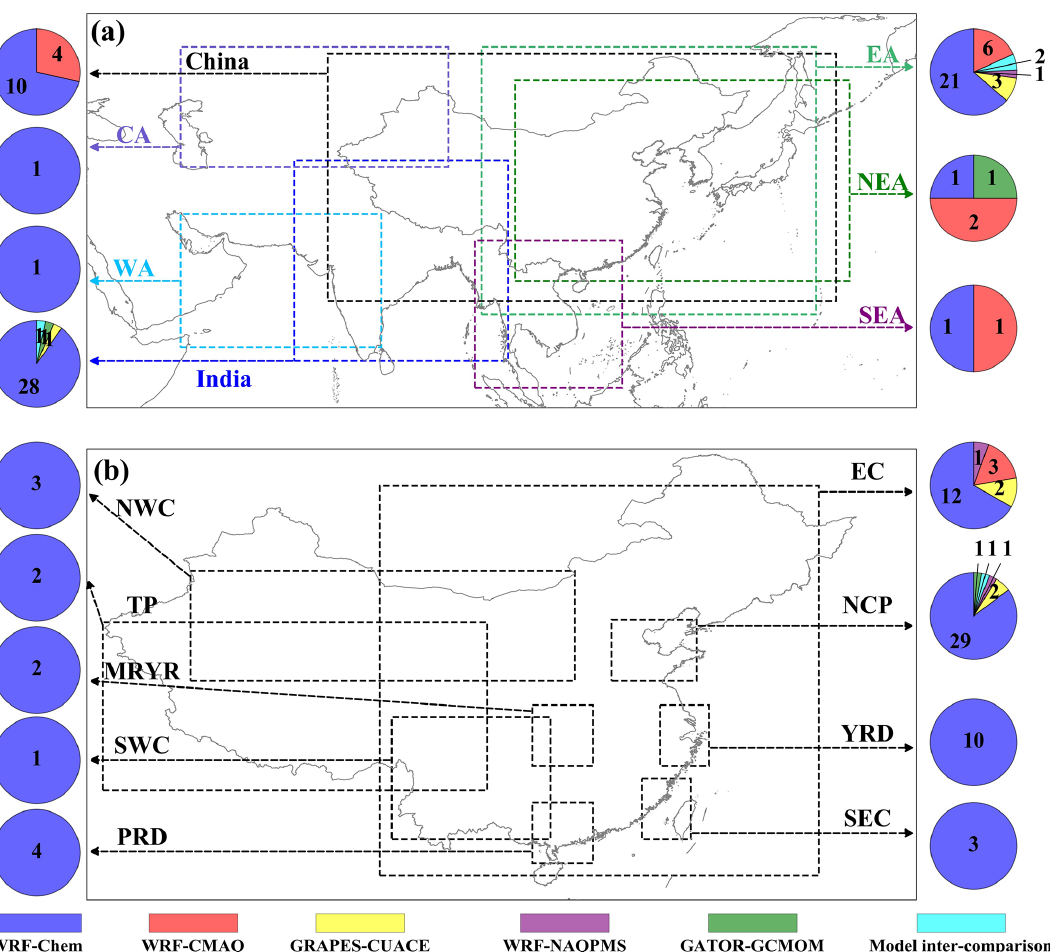
Figure 1. The spatial distributions of study domains as well as the two-way coupled modeling publication numbers in different subregions or countries of Asia (a) and areas of China (b) . (EA: East Asia, NEA: northeastern Asia, SEA: Southeast Asia, EC: eastern China, NCP: North China Plain, YRD: Yangtze River Delta, SEC: southeastern China, NWC: northwestern China, TP: Tibetan Plateau, MRYR: middle reaches of the Yangtze River, SWC: southwestern China; PRD: Pearl River